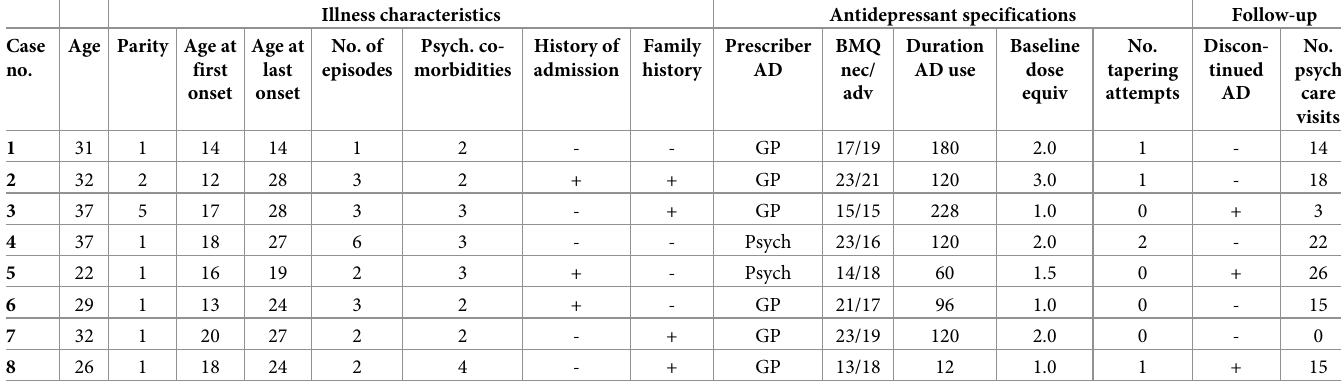
Table 2. Clinical features of women with recurrence of depression in the perinatal